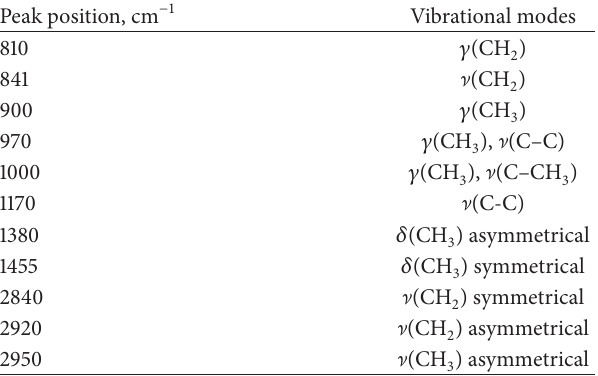
Table 2: FTIR peak assignments of